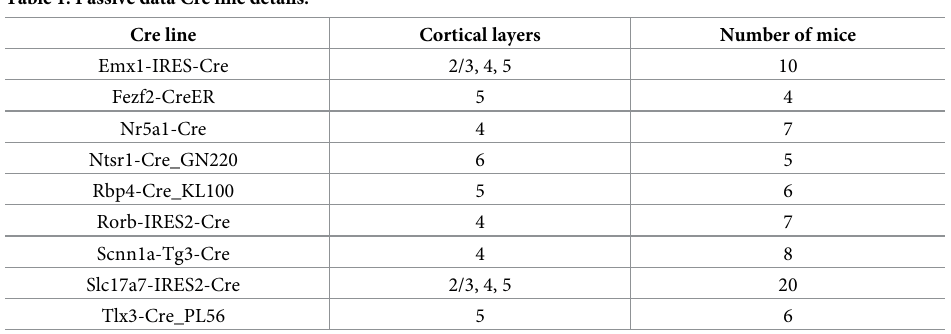
Cre-lines, cortical layers, and number of mice for the passive data